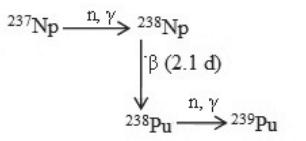
Figure 1. A chain of nuclide transformations starting with nep- tunium (Bowman 2007).